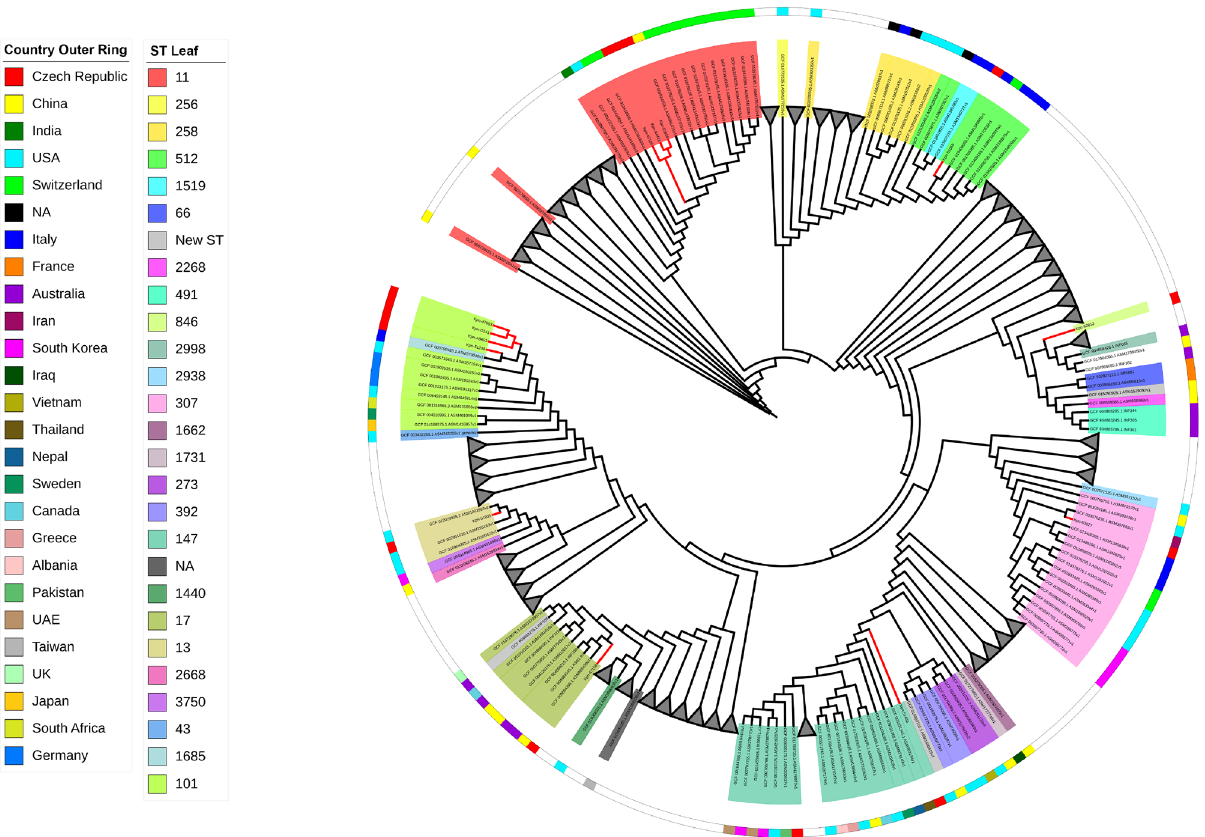
Figure 8. SNPs-based phylogeny of the 13 K . pneumoniae with 732 genomes downloaded from NCBI database. Red nodes indicate the Isolates from the study. Grey triangles indicate collapsed